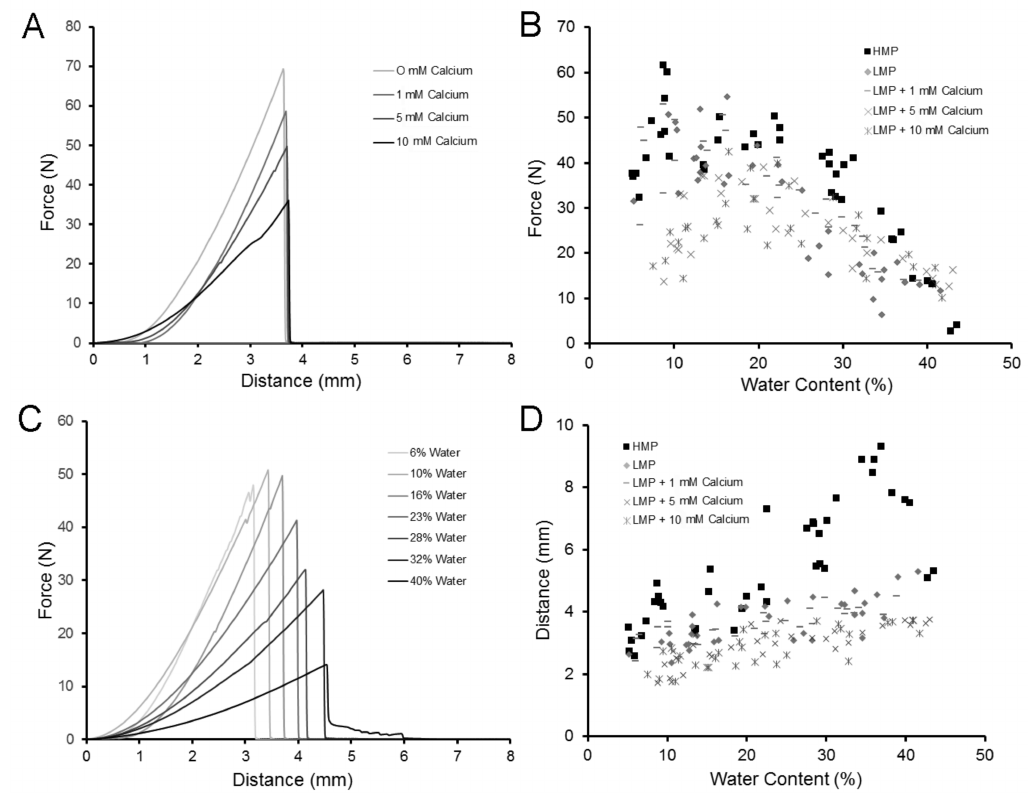
Figure 3. E ff ect of calcium concentration and water content on the burst strength and extensibility of LMP films. ( A ) In films with identical degrees of methoxylation and a similar hydration state, the addition of calcium resulted in decreased burst strength. ( B ) The burst strength of the LMP films was generally less than that of HMP, regardless of the calcium concentration or water content. ( C ) Increasing the water content of LMP films (without calcium) resulted in a decreased burst strength, but increased extensibility. ( D ) Similar to burst strength, the extensibility of the HMP films was greater than that of LMP films, regardless of the calcium concentration or water